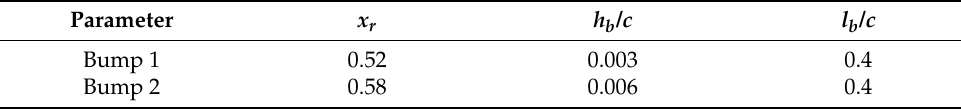
Table 3. Optimized bump